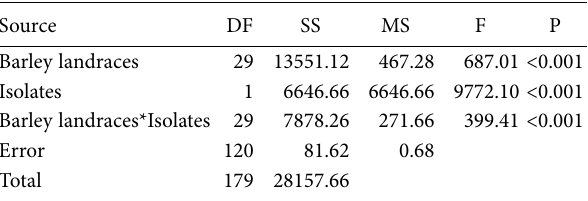
Table 4. Analysis of variance for the resistance of 30 barley landrac- es 60 d after planting following seed inoculation with two isolates of Drechslera graminea